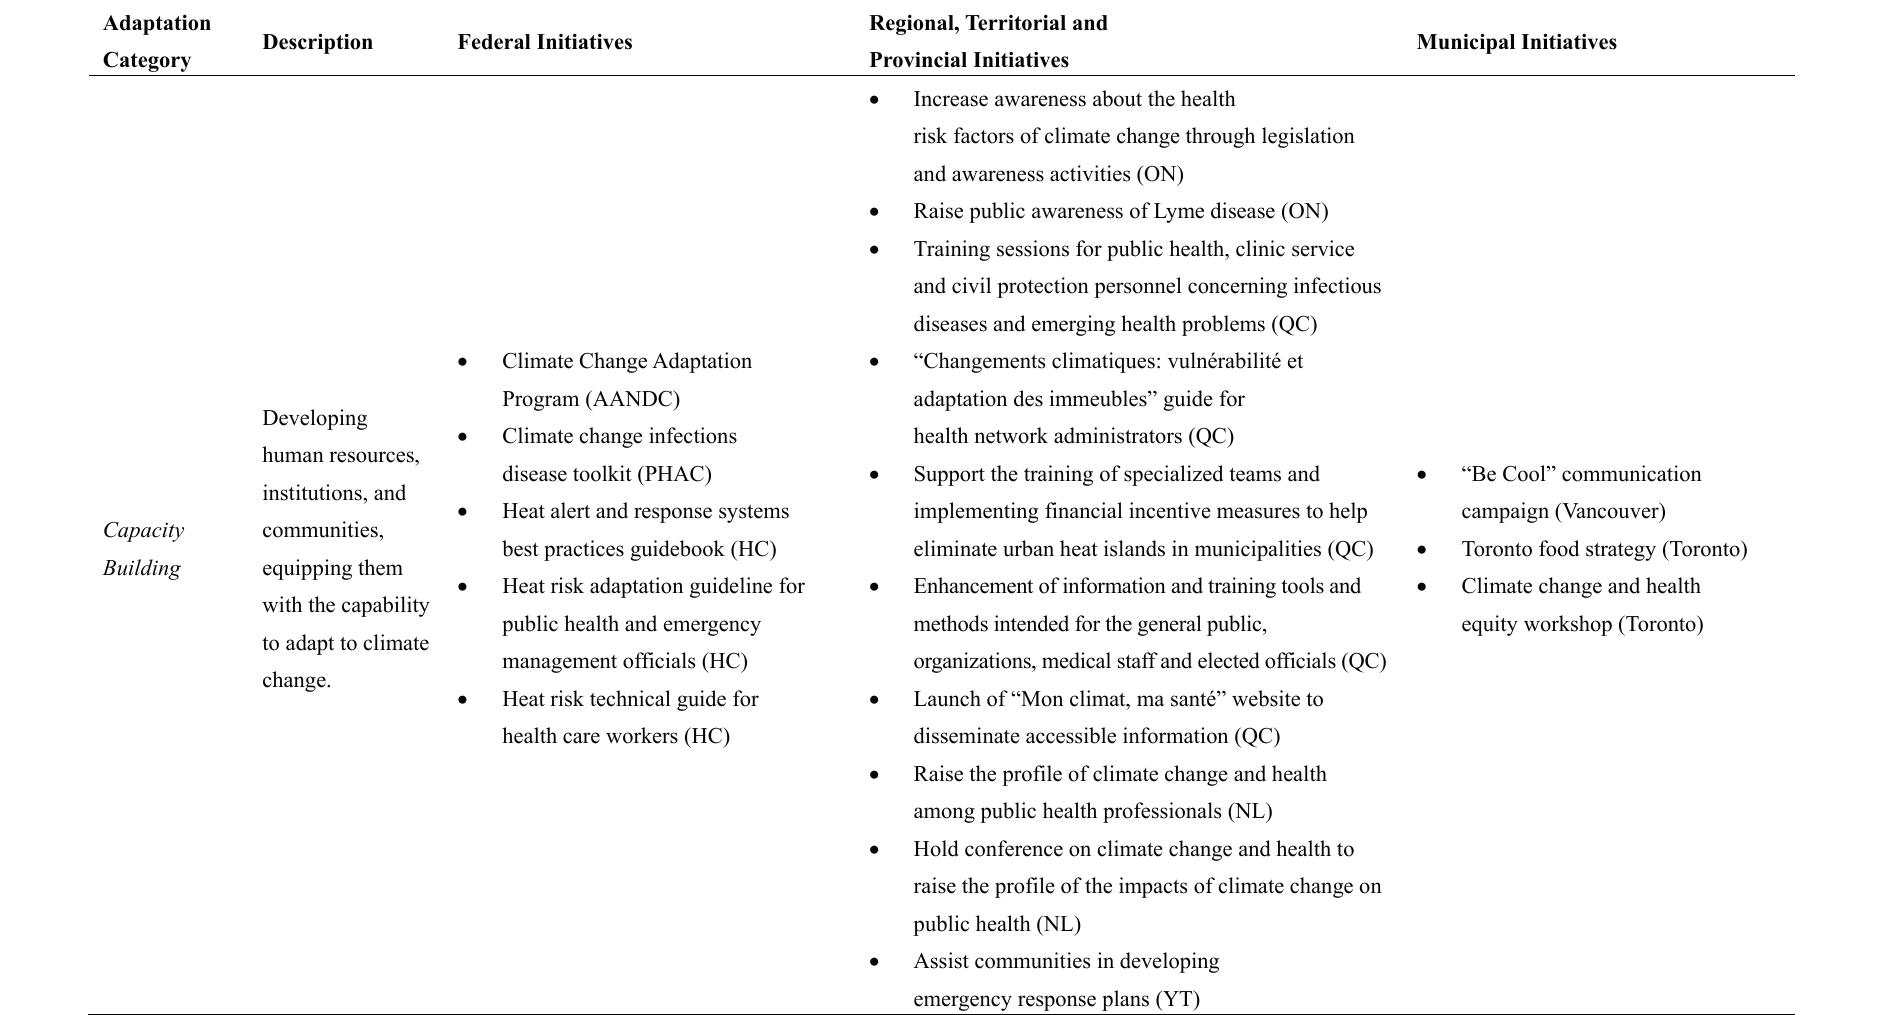
Table 2. Health adaptation initiatives included, by adaptation